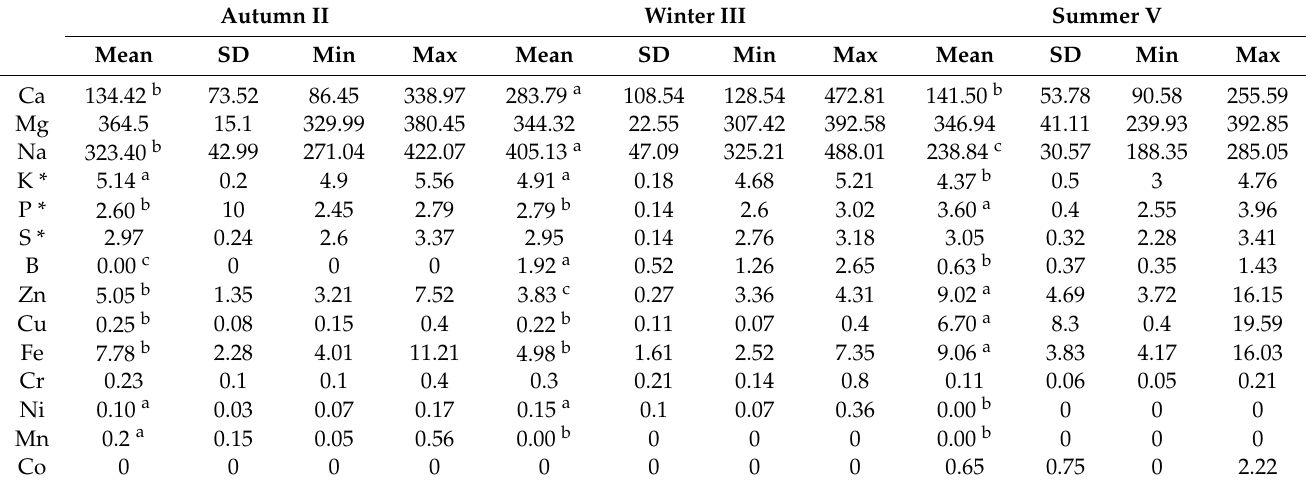
Table 3. Fish metal contents during seasons expressed as mg kg − 1 fresh weight; sd = standard